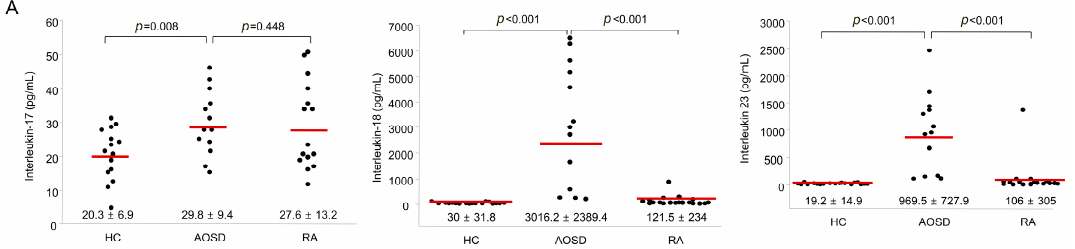
Figure 3. ( A ) Levels of serum interleukin-17 (IL-17), IL-18, and IL-23 in AOSD patients, RA patients, and healthy controls (HC). The horizontal line indicates the mean value for each group. The p -value was determined with the Mann–Whitney U -test; ( B ) Levels of serum IL-17, IL-18, and IL-23 according to disease activity in patients with AOSD. The horizontal line indicates the mean value for each group. The p -value was determined with the Mann–Whitney U -test. 2.4. Percentages of Surface-Stained Cells Presenting CD11b, CD11c, CD32, CD206, CD209, and Dectin-1, and Serum Levels of IL-17, IL-18, and IL-23 According to Disease Activity in AOSD Patients Only five patients were available for examination in both the active and inactive phases. Therefore, we compared the frequencies of cells presenting CD11b, CD11c, CD32, CD206, CD209, and dectin-1 between 13 active AOSD patients and five inactive AOSD patients using follow-up data (Figure 4). The frequencies of circulating CD11b and CD11c were not different between active and inactive phases. Significantly lower mean frequencies of cells presenting CD32 from monocytes were observed in patients with active AOSD (78.7% ± 13.9%) than in patients with inactive AOSD (94.4% ± 4.8%, p = 0.004). Also, significantly higher frequencies of cells presenting CD32 from lymphocytes were observed in patients with active AOSD (14.1% ± 7.6%) than in those with inactive AOSD (7.6% ± 2.9%, p = 0.04). The frequencies of CD206 from whole blood cells were increased in patients with active AOSD (21.1% ± 10.2%) versus inactive AOSD (9.9% ± 10.5%, p = 0.019). The frequencies of CD206 from granulocytes and lymphocytes were increased in patients with active AOSD versus inactive AOSD ( p = 0.019 and 0.01, respectively). The frequencies of CD209 from whole blood cells were increased in active AOSD patients (2.8% ± 2.2%) versus inactive AOSD patients (0.3% ± 0.4%, p = 0.04). The frequencies of CD209 from granulocytes, monocytes, and lymphocytes were increased